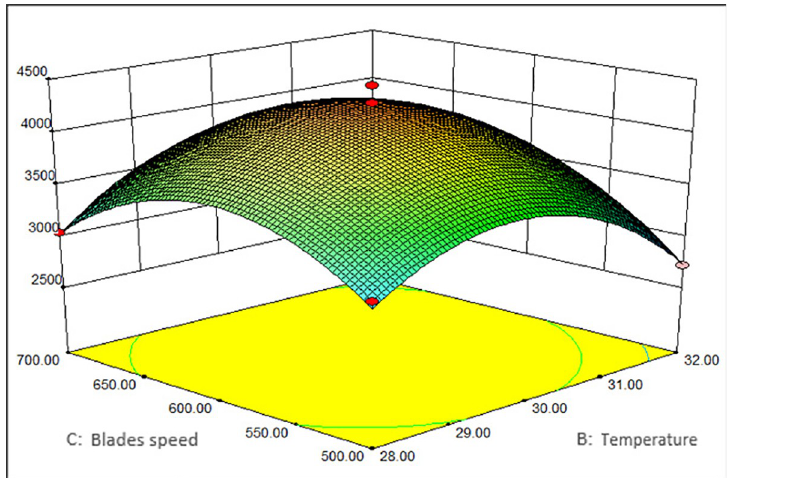
Fig 3. Interaction of temperature and blades speed vs. the yield of